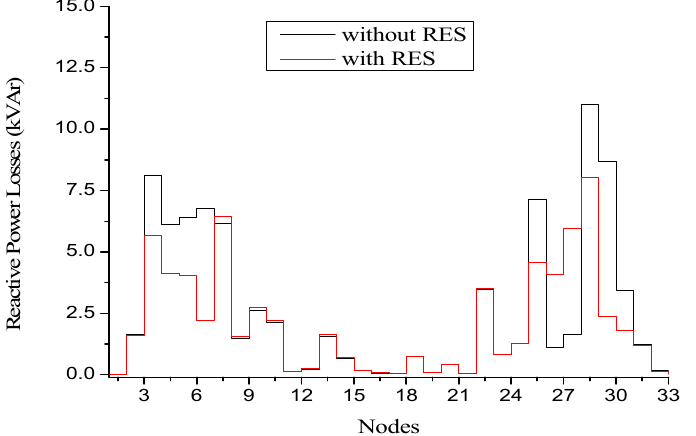
Figure 4. Active power losses with and without the integration of RES.